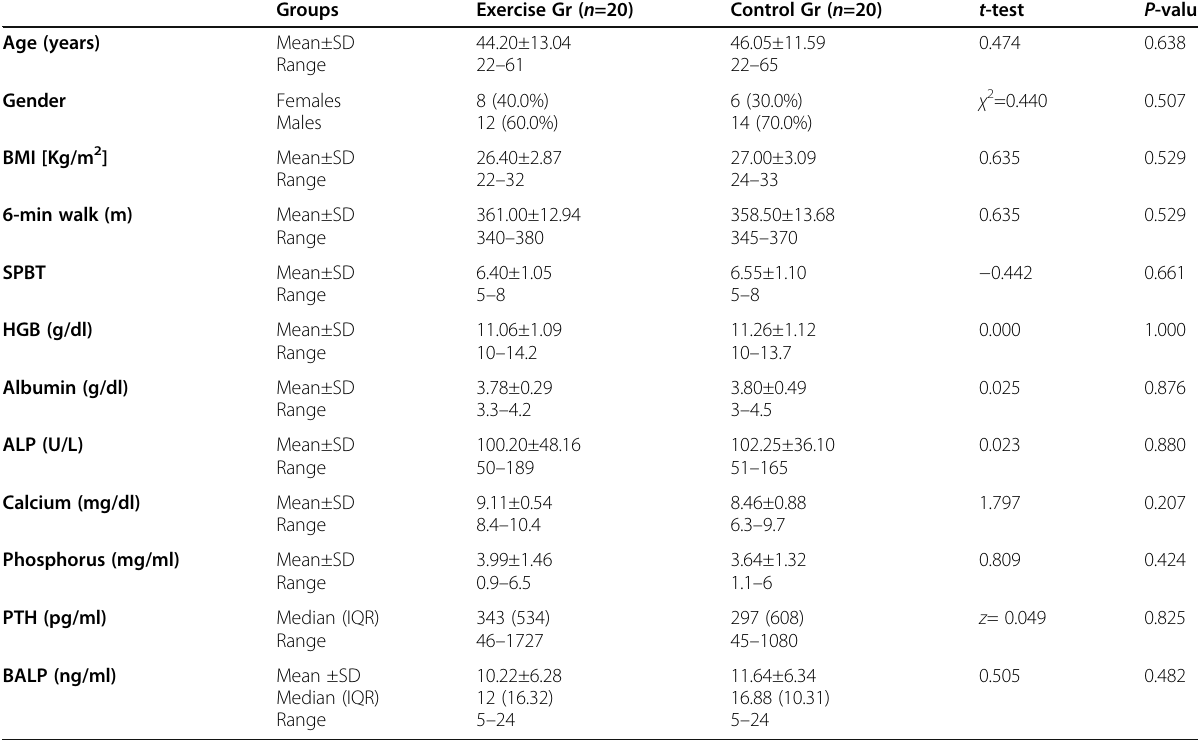
Table 1 Comparison between exercise and control group regarding baseline demographic data, physical performance scores and laboratory